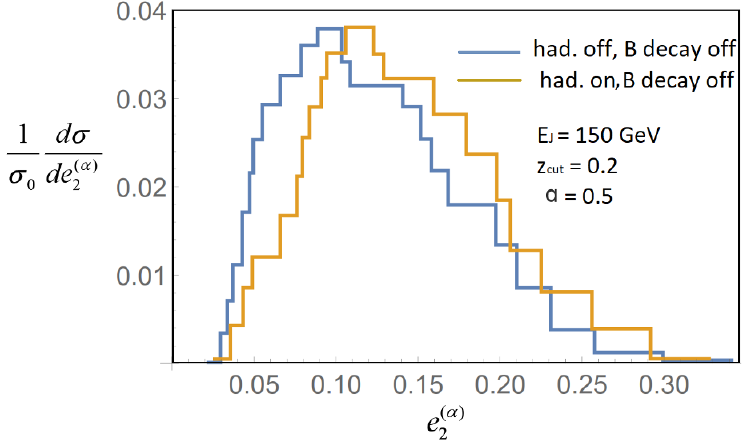
Figure 13 . Comparison of resummed perturbative cross section at NLL for the massless and massive quark initiated jets. Note that these curves include no nonperturbative corrections or (cid:12)xed-order matching.